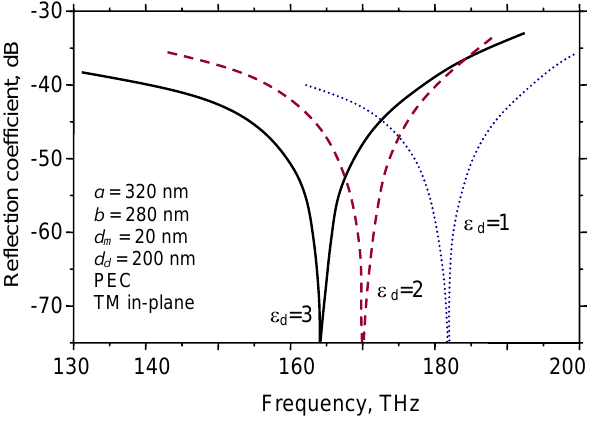
Figure 14. Reflection from a metal-dielectric-metal symmetric freestanding fishnet MM with circular holes. Geometrical dimensions and analyte properties are shown.